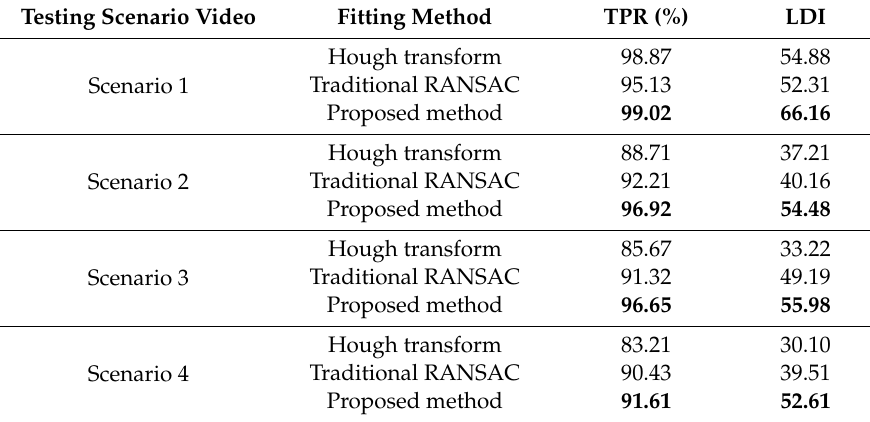
Table 5. Comparative results of fitting methods in di ff erent test